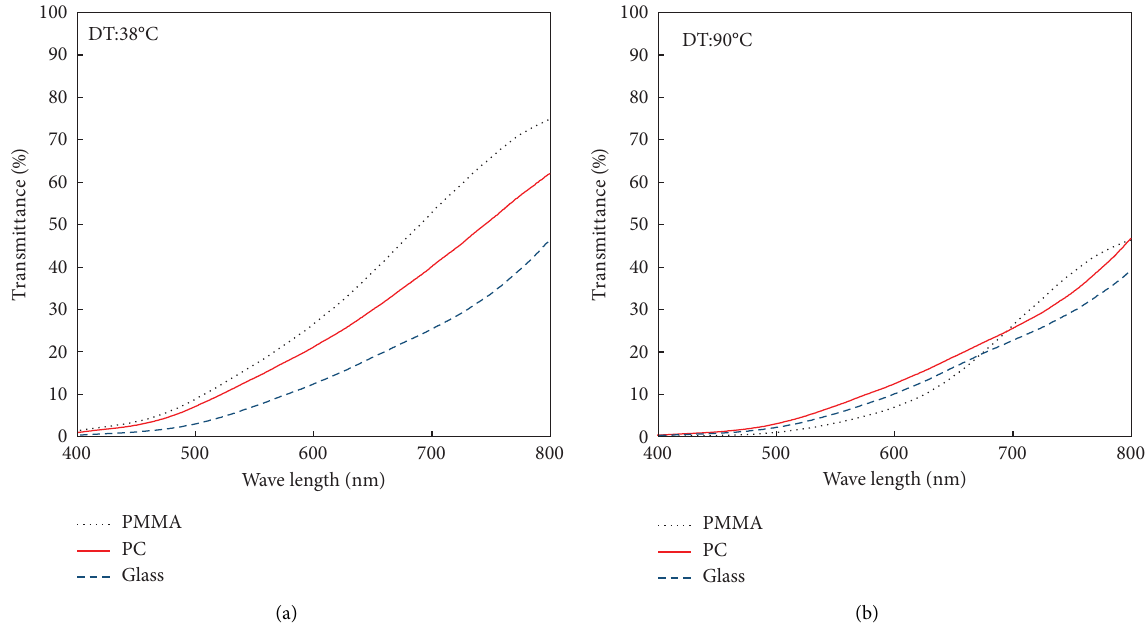
Figure 4: Transmittance of samples (a, b) that formed at 10W on PMMA, PC, and glass substrates.